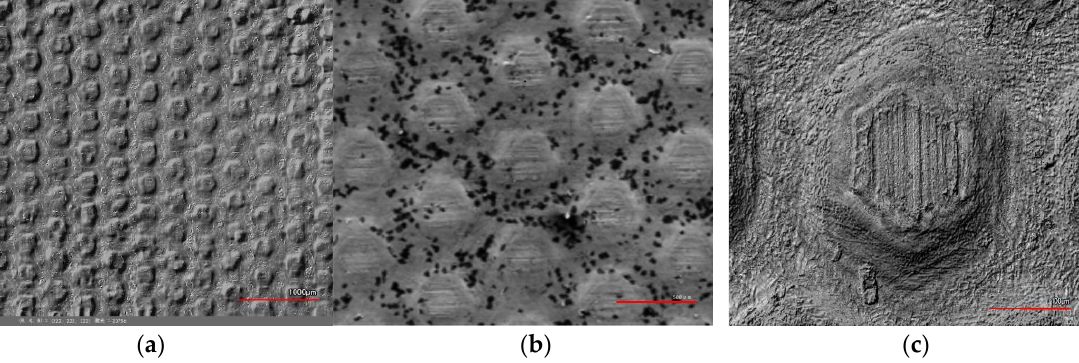
Figure 16. Diagrams of laser processing ortho-hexagonal bosses at different scales. ( a ) 1000 μm, ( b ) 500 μm, ( c ) 100 μm.